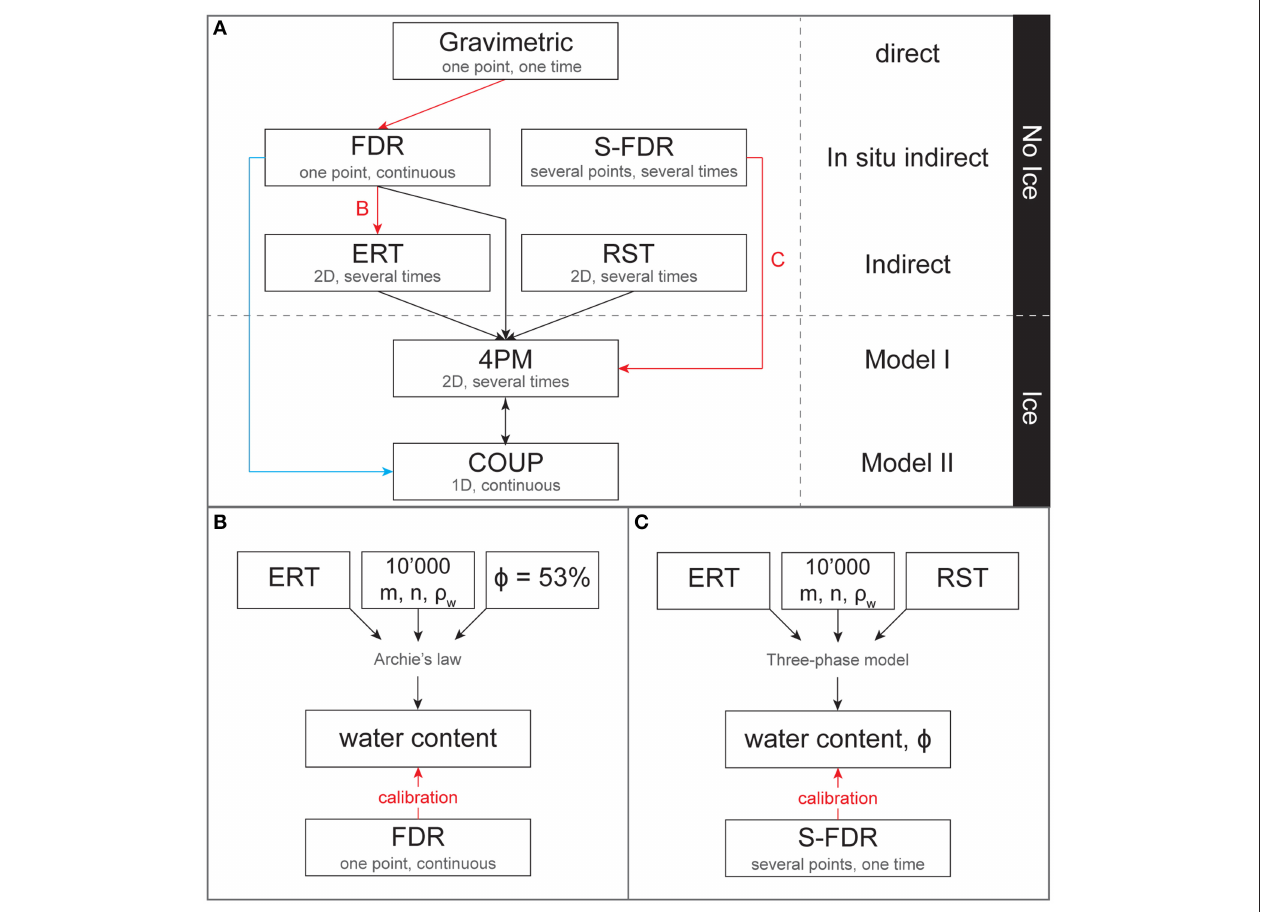
FIGURE 1 | (A) Schematics of the overall methodological concept and set of methods applied to assess water content. The red arrows represent calibration process, the blue the validation process. The specific calibration procedure for (B) Archie’s law and (C) the 4PM are also shown. The number 10,000 indicates hereby the number of random combinations of the Archie parameters m, n and the pore water resistivity ρ w . 8 is the porosity, taken from Scherler (2006) in B and calibrated in C.